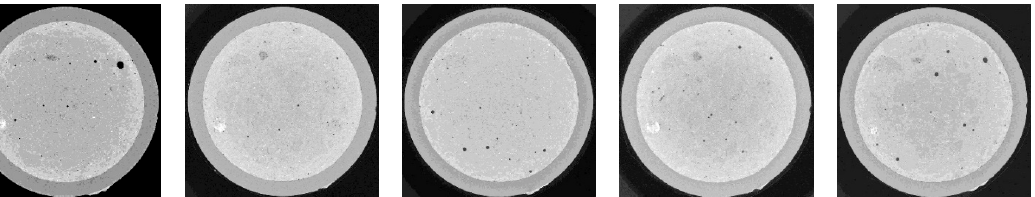
Figure 2. Slices belonging to plain concrete at different ages.